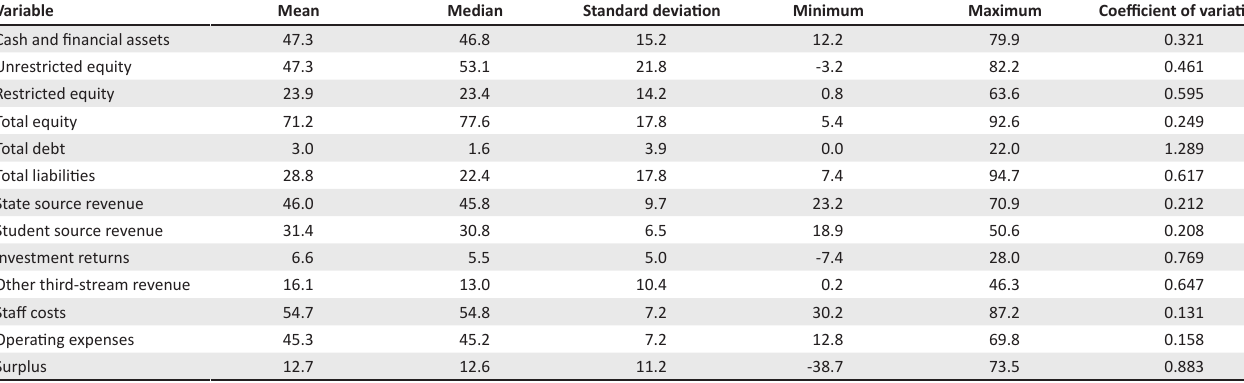
TABLE 4: Descriptive statistics: South African universities 2007–2016 (common-size analysis). Variable Mean Median Standard deviation Minimum Maximum Coefficient of